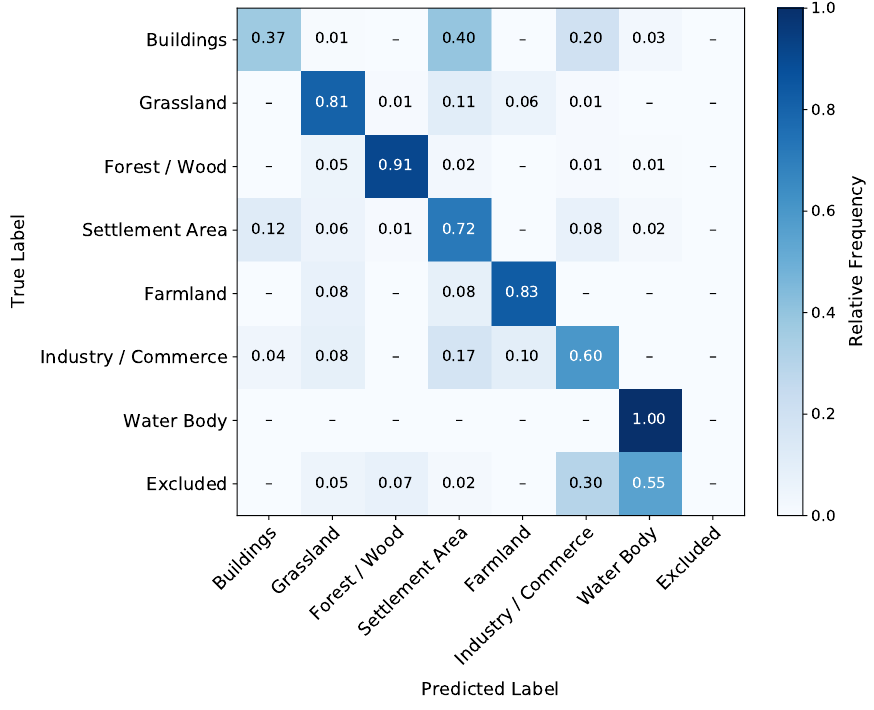
Figure 9. Normalized confusion matrix for the best-scoring ensemble of LSTM V models. The predic- tion is performed on the test subset of the 2016 data and compared to the